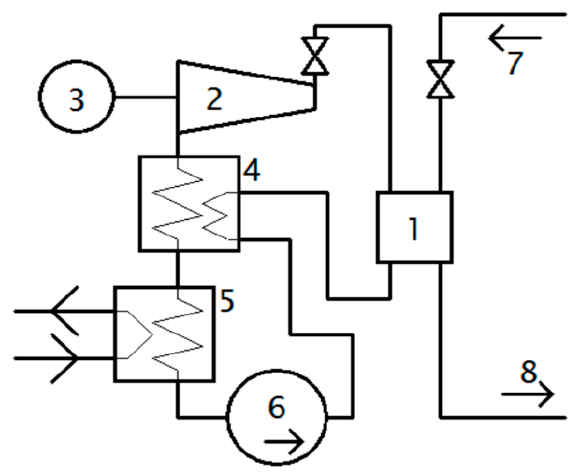
Figure 7. ORC topology with subcritical critical curve [6,8].